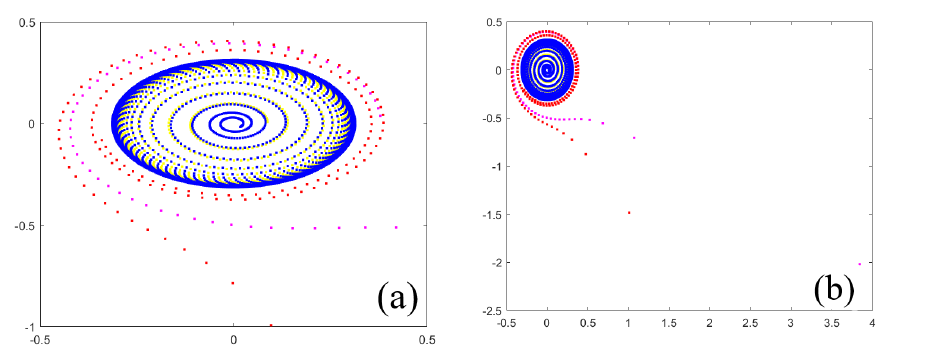
+ α + α 2 , β 2 ( α ) = 1 α 2 2 1